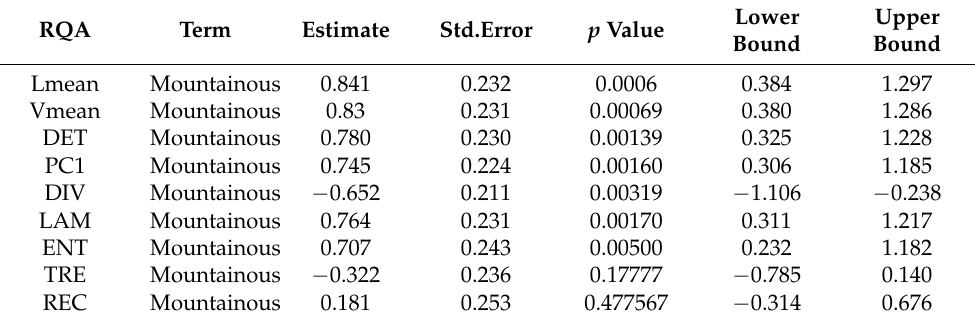
Table 2. Linear mixed-effect models of log-transformed RQA metrics as a function of mountainous setting (in comparison to the urban setting) accounting for the repeated measurements. RQA Term